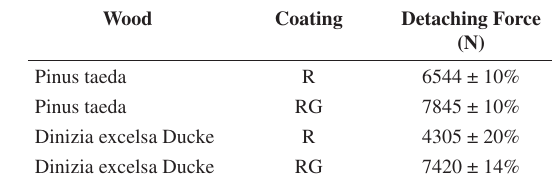
Table 7. Maximum force applied in the adhesion test on coated samples with resin and resin and geotextile.